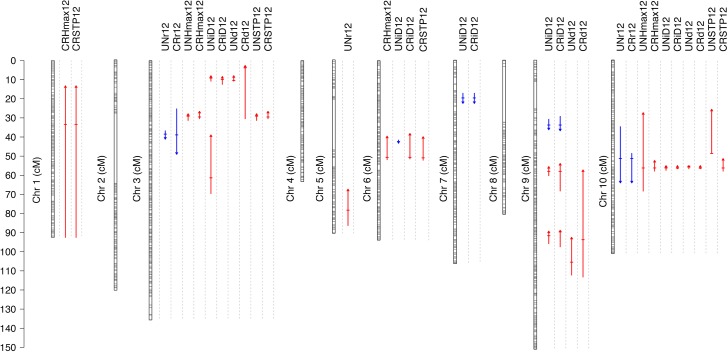
A map of all QTL identified in 2012.Horizontal lines on chromosomes indicate the position of RNAseq markers used to genetic map construction. Each QTL is indicated with a vertical arrow under the trait name. Horizontal hatches indicate QTL position, the arrow length indicates 1.5 LOD support limits. Arrow heads and color (up, red = positive; down, blue = negative) indicate QTL direction relative to the R500 parent. Exact locations, markers, and LOD scores for all QTL can be found in S1 (Table).